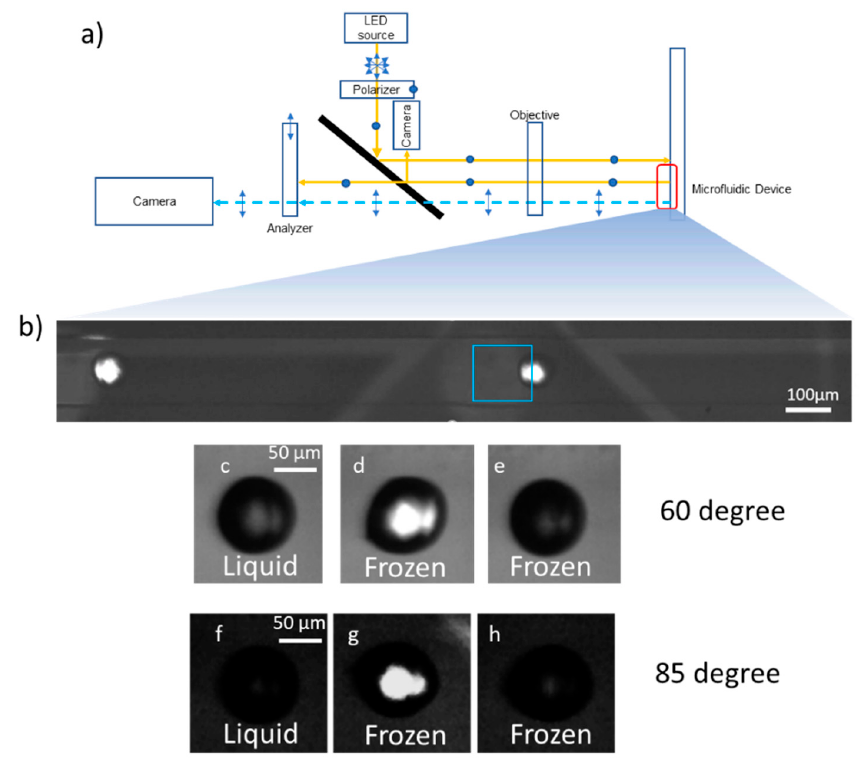
Figure 5. Experimental setup and freezing detection algorithm using a polarized intensity threshold method: ( a ) Polarized imaging optical path; ( b ) Region of interest highlighted in blue inside the flow channel; ( c – h ) Liquid, frozen (bright) and frozen (dark) droplets as they appear inside the region of interest for different analyzer angles